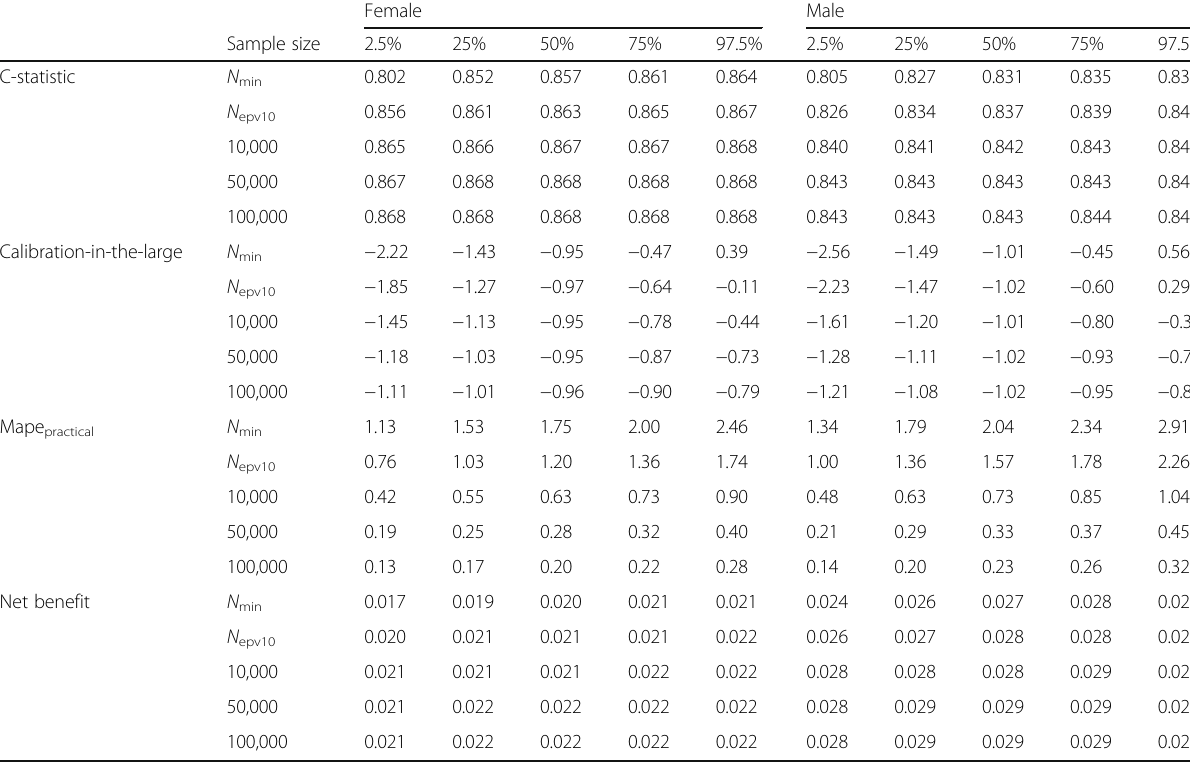
Table 2 Quantiles of C-statistic, calibration-in-the-large MAPE practical and net benefit of the 1000 models, for each sample